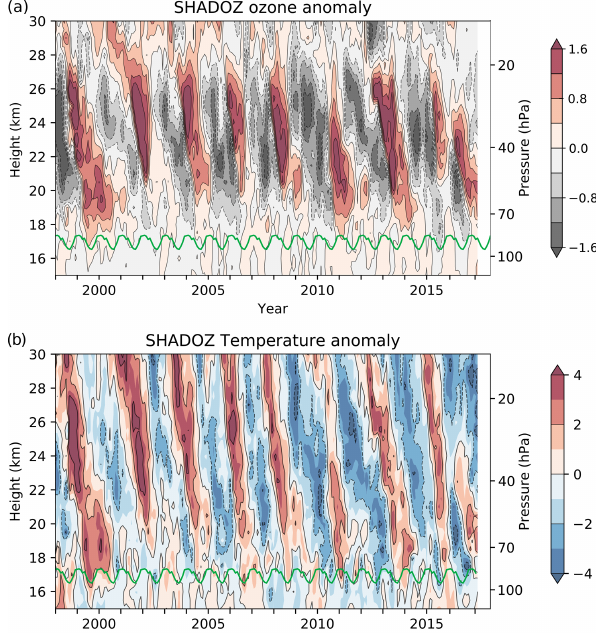
Figure 3. Height–time sections of deseasonalized anomalies in (a) ozone and (b) temperature (K) from SHADOZ data. Ozone anomalies are expressed in terms of ozone density (DU/km) to em- phasize variability throughout the lower stratosphere. The green lines denote the cold-point tropopause.